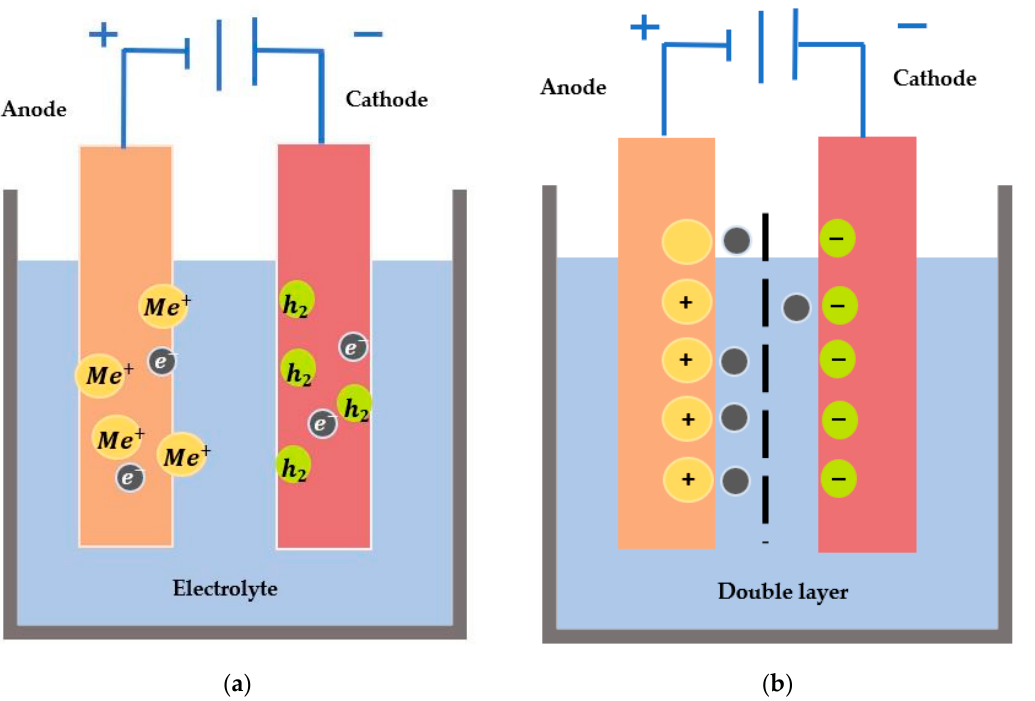
Figure 2. ( a ) Fundamental kinetics of electropolishing showing anodic dissolution and cathodic reduction, ( b ) The formation of the double layer when electrodes are immersed in an electrolyte and move across the barrier.